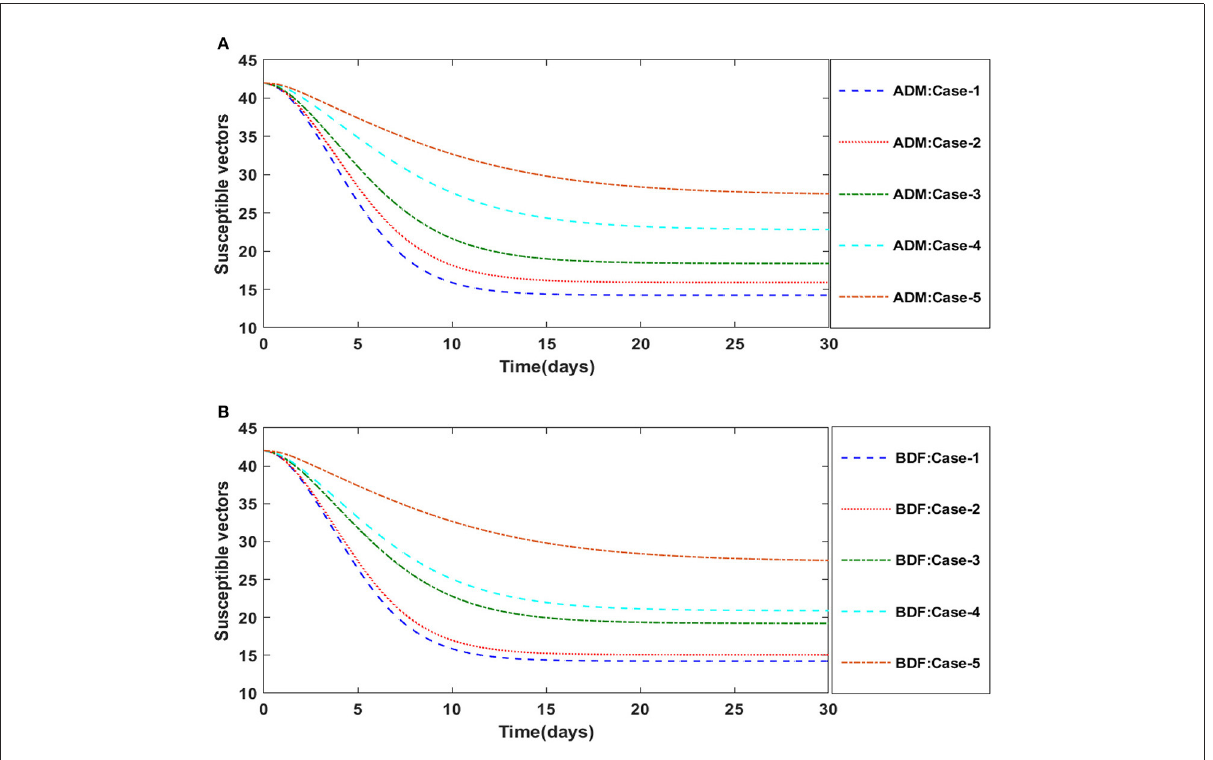
FIGURE16 (A) Dynamics of susceptible vectors for the varition in d using ADM for model B. (B) Dynamics of susceptible vectors for the varition in d using BDF for model B.